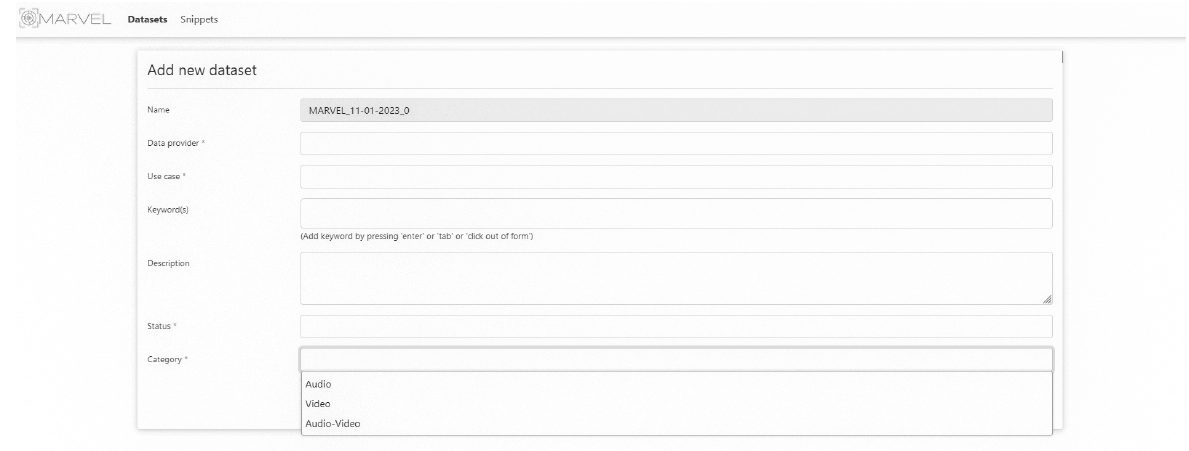
Figure 7. GUI: main dashboard (add new dataset).